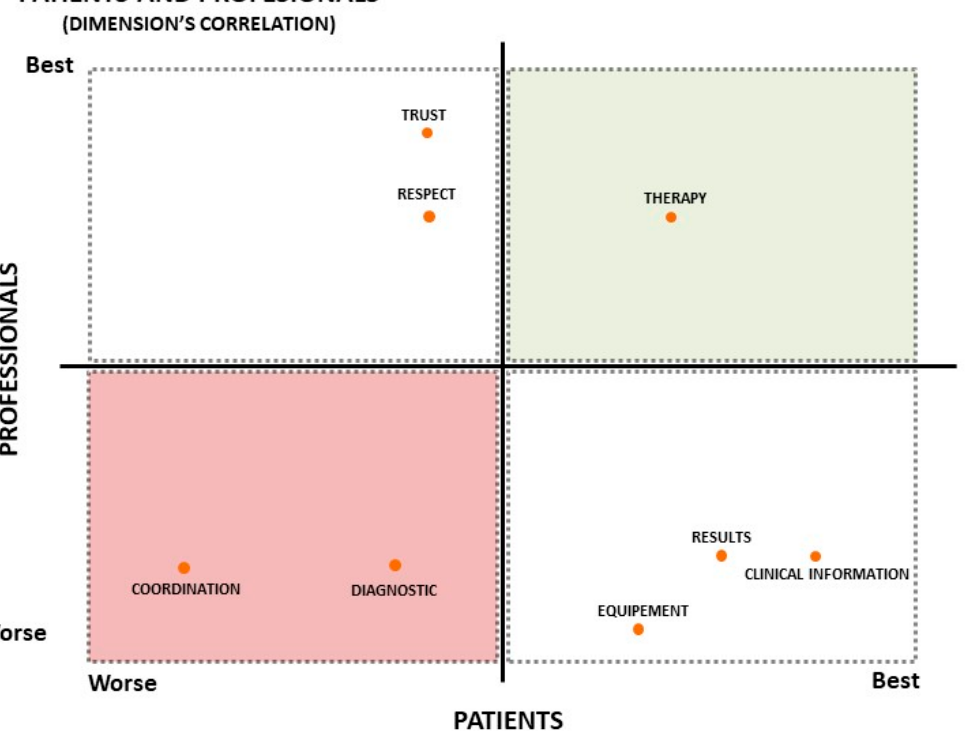
Figure 2. Quadrants of coincidences and divergences between professionals and patients. The red dots express the perceptions of patients and professionals. The red quadrant contains the categories worst rated by both. The green quadrant contains the categories most highly rated by both.